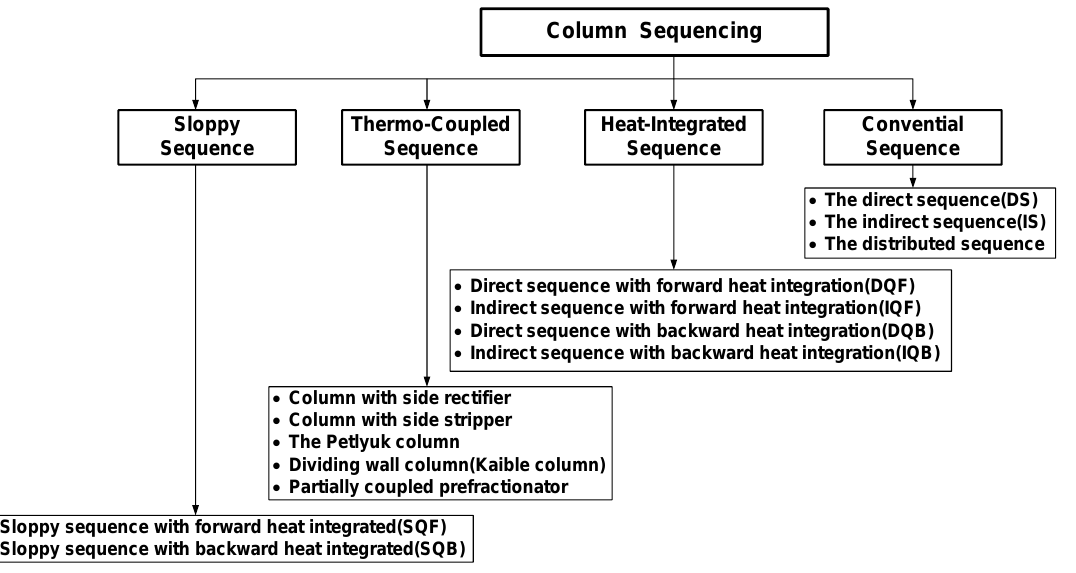
Figure 1. The possibilities of column sequencing for separating ternary